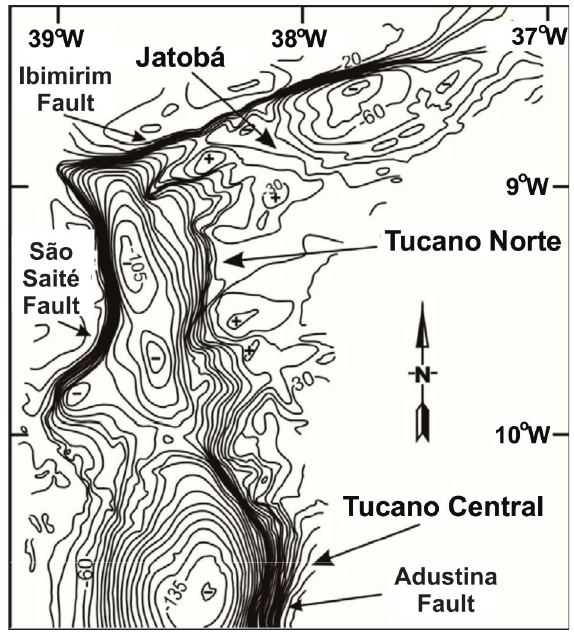
Figure 11. Map of gravimetric anomalies in the Tucano Norte Sub-basin and Jatobá Basin (modified from Magnavita 1992), showing the depocentres of the sub- basin and basin. The contour lines are in